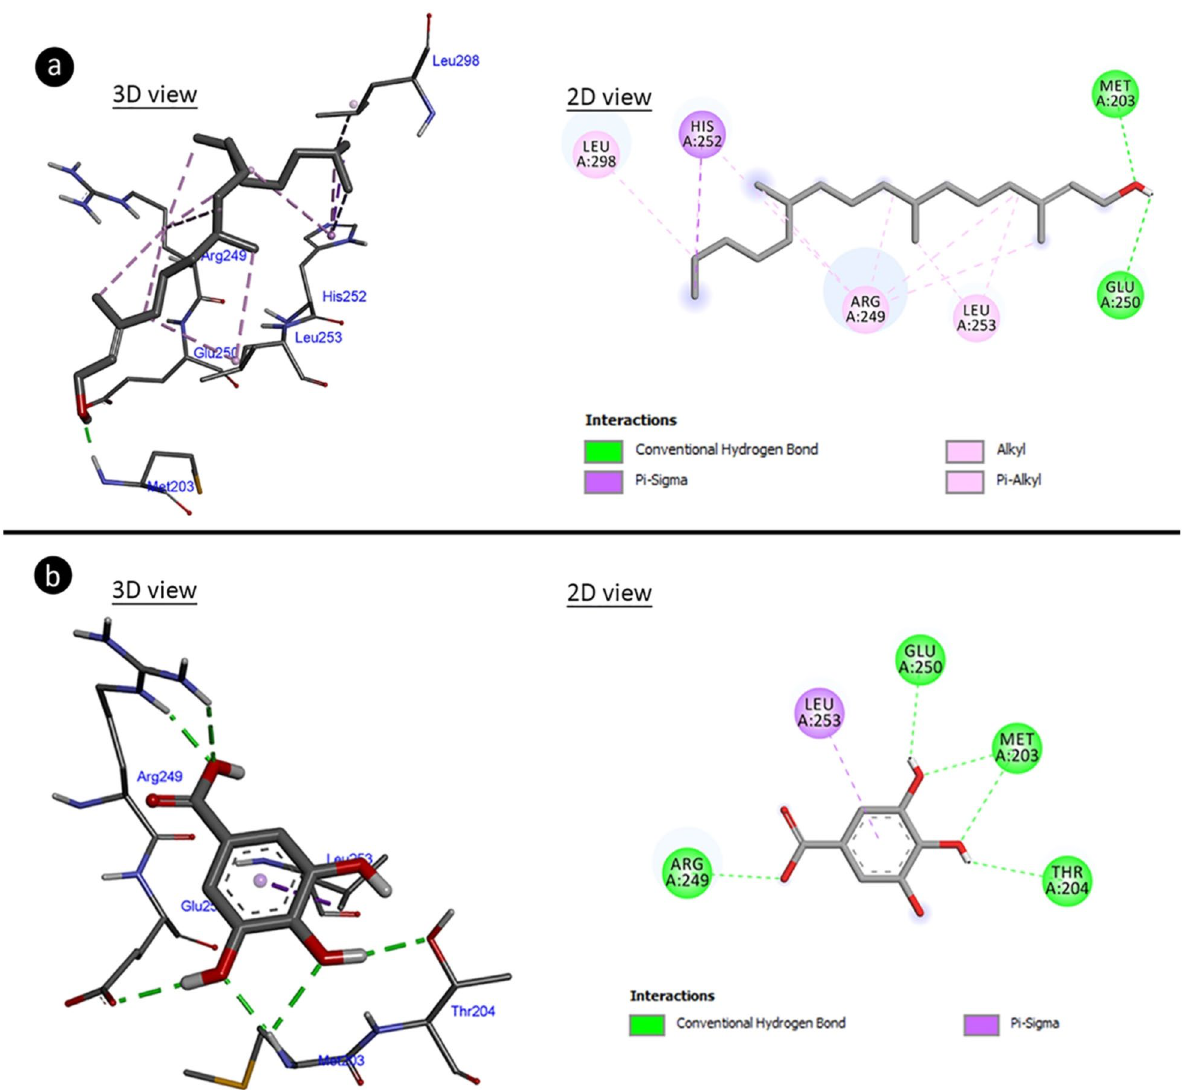
Figure 6. Molecular docking of gallic acid and phytol with telomerase. ( a ) Telomerase-phytol complex, ( b ) telomerase-gallic acid complex.